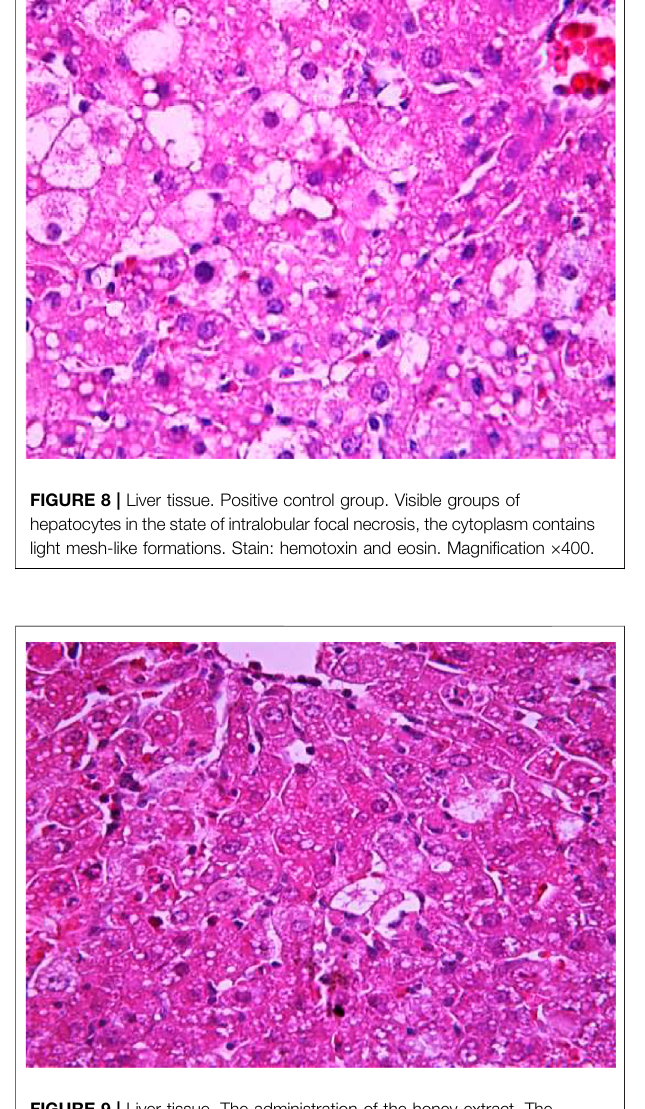
FIGURE 9 | Liver tissue. The administration of the honey extract. The restoration of the linear cord structure of the liver lobule is noted. The central vein and capillaries of sinusoids are fi lled with blood. Stain: hemotoxin and eosin. Magni fi cation × 100.